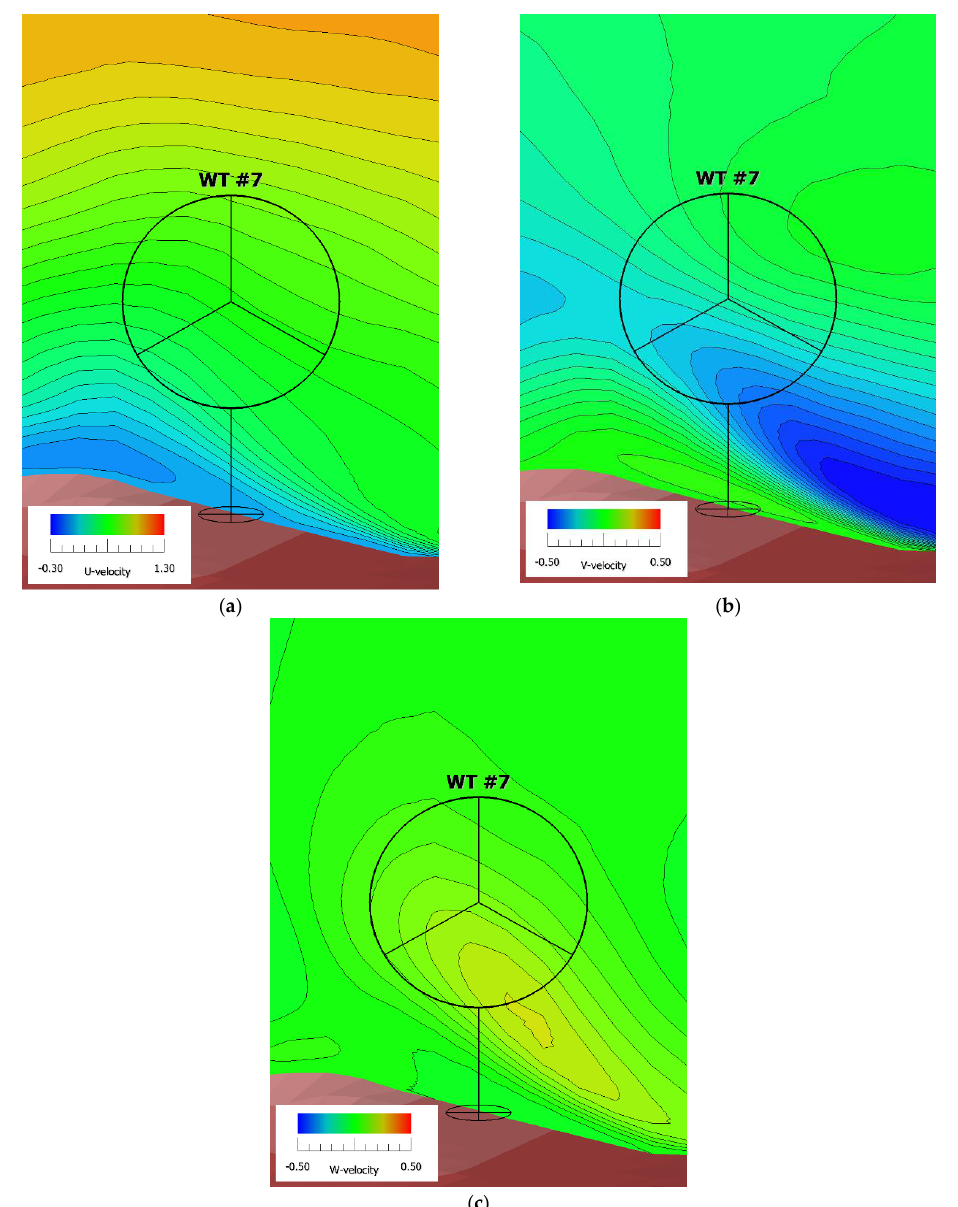
Figure 26. Spatial distribution of each velocity component in the swept rotor area of WT #7 for the time-averaged flow field in the case of north-westerly wind: ( a ) Streamwise velocity component, ( b ) spanwise velocity component, and ( c ) vertical velocity component.